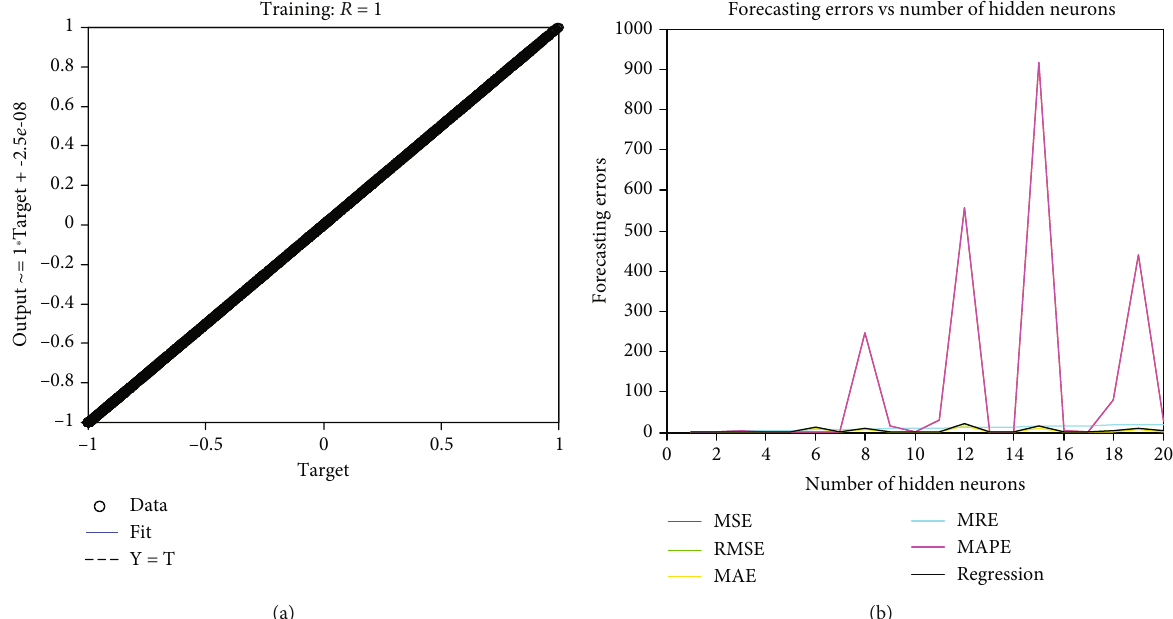
Figure 21: (a) CMMLPNN-based forecasting model regression graph. (b) CMMLPNN-based forecasting model forecasting error vs. the number of hidden neurons.